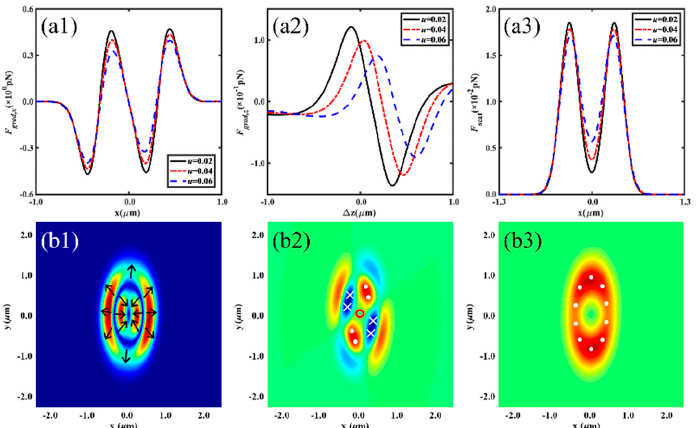
Figure 8. ( a ) The radiation force produced by rotating anisotropic generalized multi-Gaussian Schell model (RAGMGSM) beam with different u on the Rayleigh particle; ( b ) The distribution of radiation force near the trapped plane with u = 0.04 mm − 2